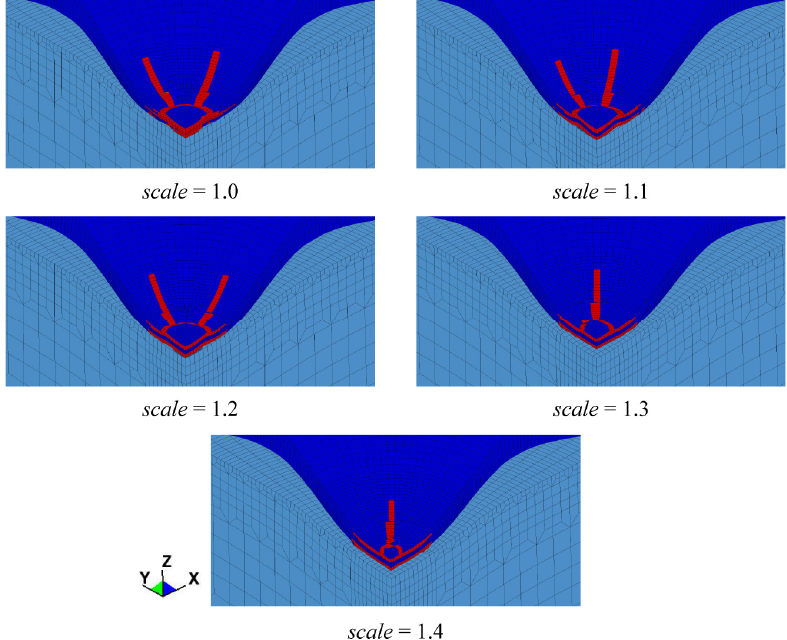
Figure 20. Final failure patterns of automotive coatings with different re-hardening moduli of pri- mer.